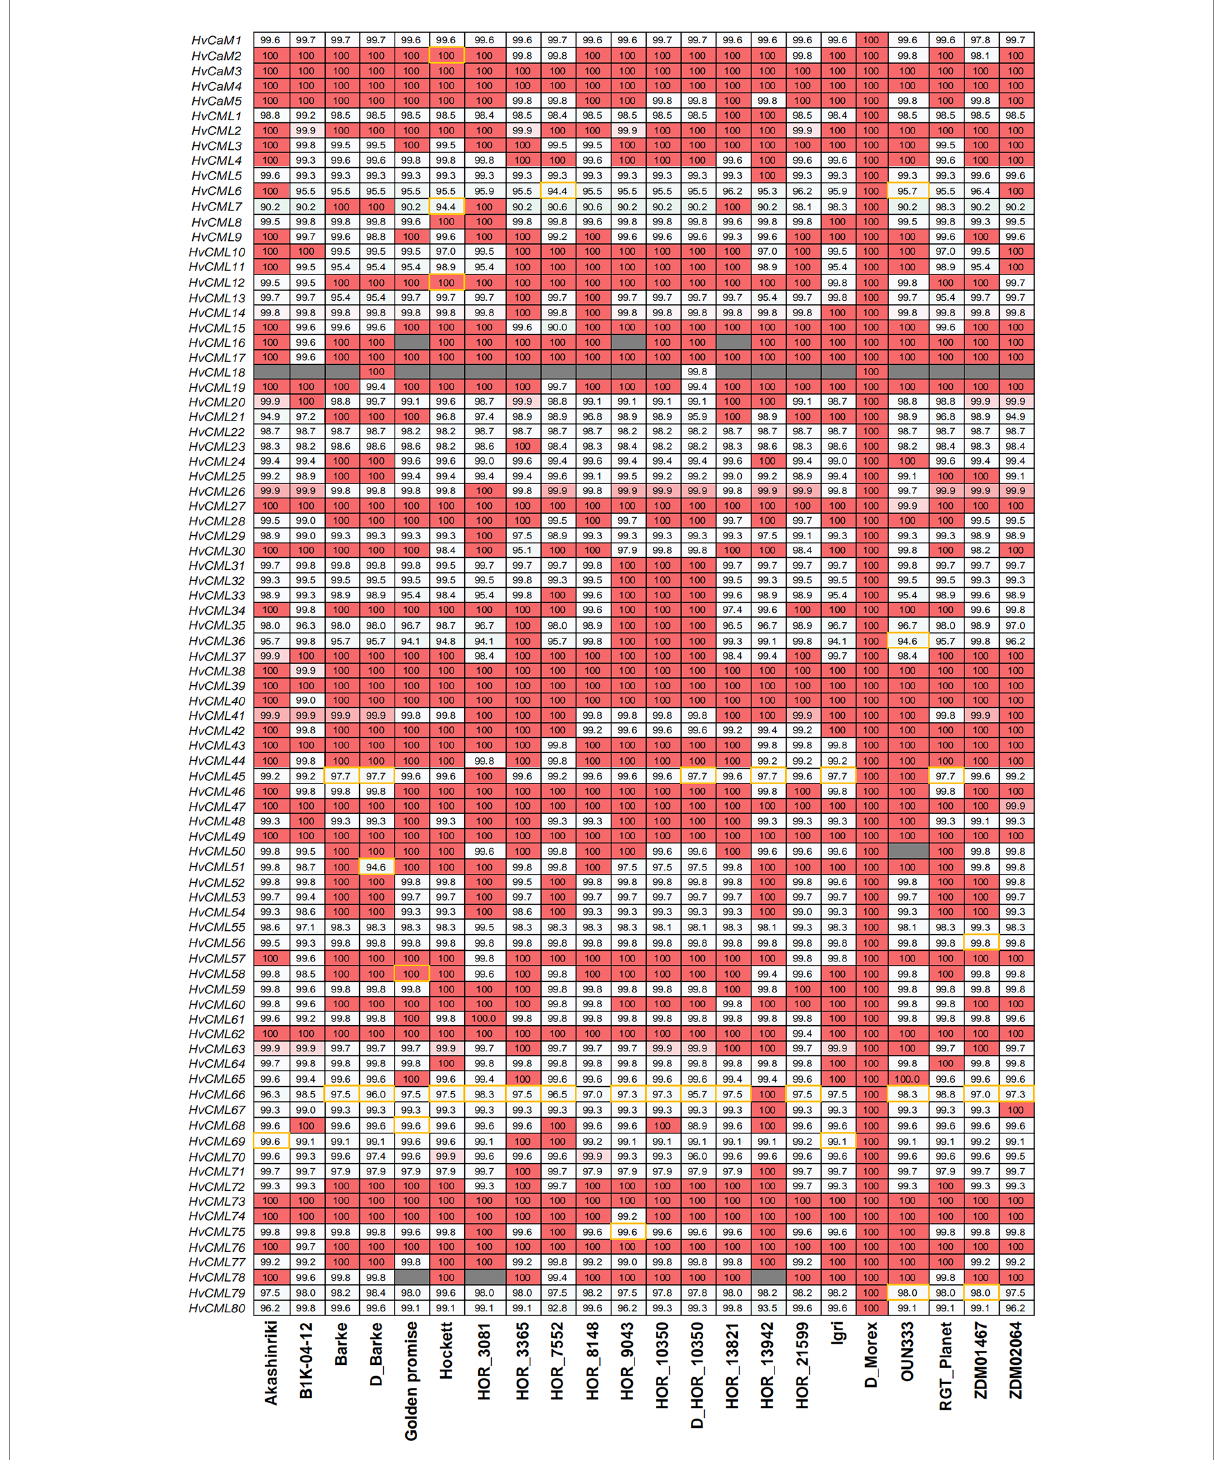
FIGURE 6 Nucleotide sequence identity of HvCaMs/CMLs between barley genotypes. Sequences of HvCaMs/CMLs in Morex were used as Blastn queries and the percent identity was designated in grids. Grids filled with gray indicated gene absence variation and those framed with yellow indicated discrepancies of chromosomal location between query and best